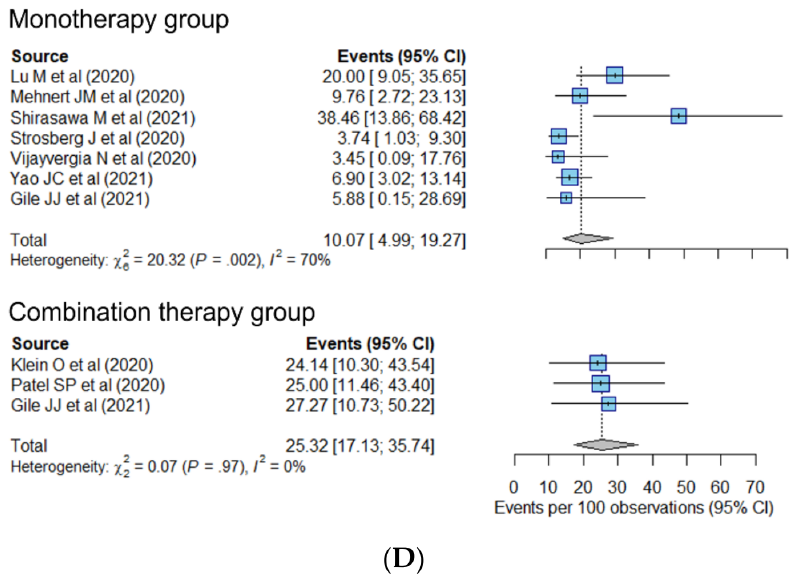
Figure 2. Forest plots showing the pooled estimate of the overall response ratio of ( A ) all studies, and of subgroups stratified by ( B ) the primary site, ( C ) tumor differentiation, and ( D ) drug regimen. The pooled overall response rate was 15.5% for all studies ( A ), 9.5% in the GEP group and 24.7% in the thoracic group ( B ), 10.4% in the WD group and 22.7% in the PD group ( C ), and 10.1%